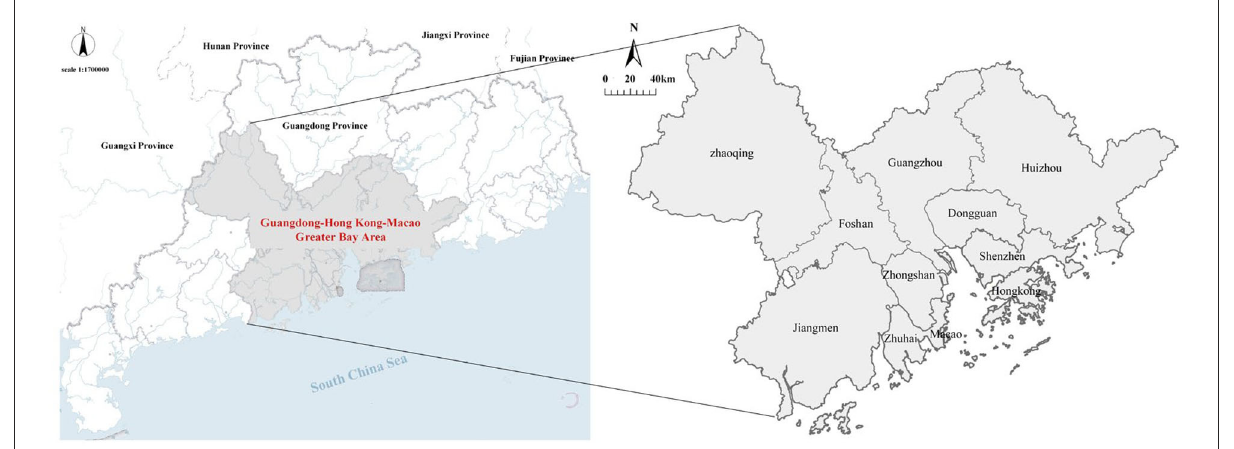
FIGURE2 Location of the GBA.